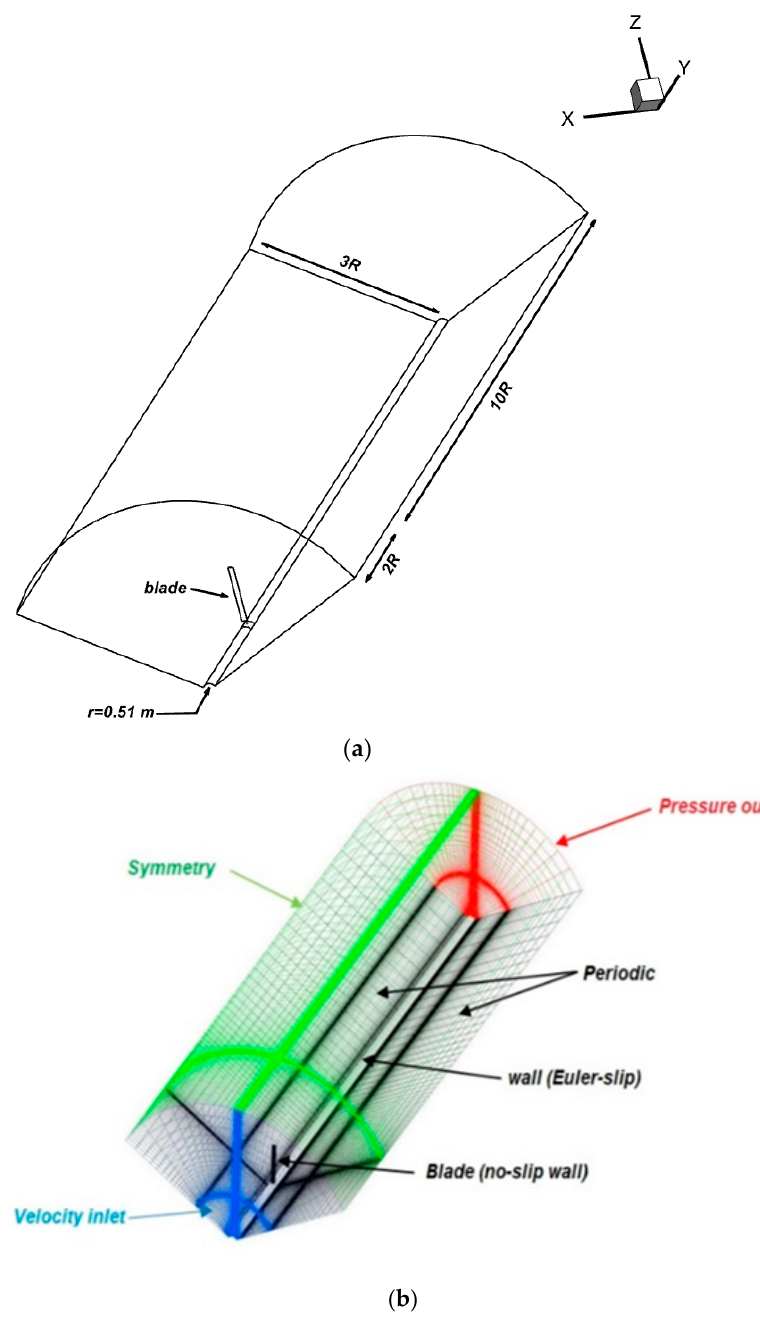
Figure 2. ( a ) Computational domain and ( b ) grid and boundary conditions.